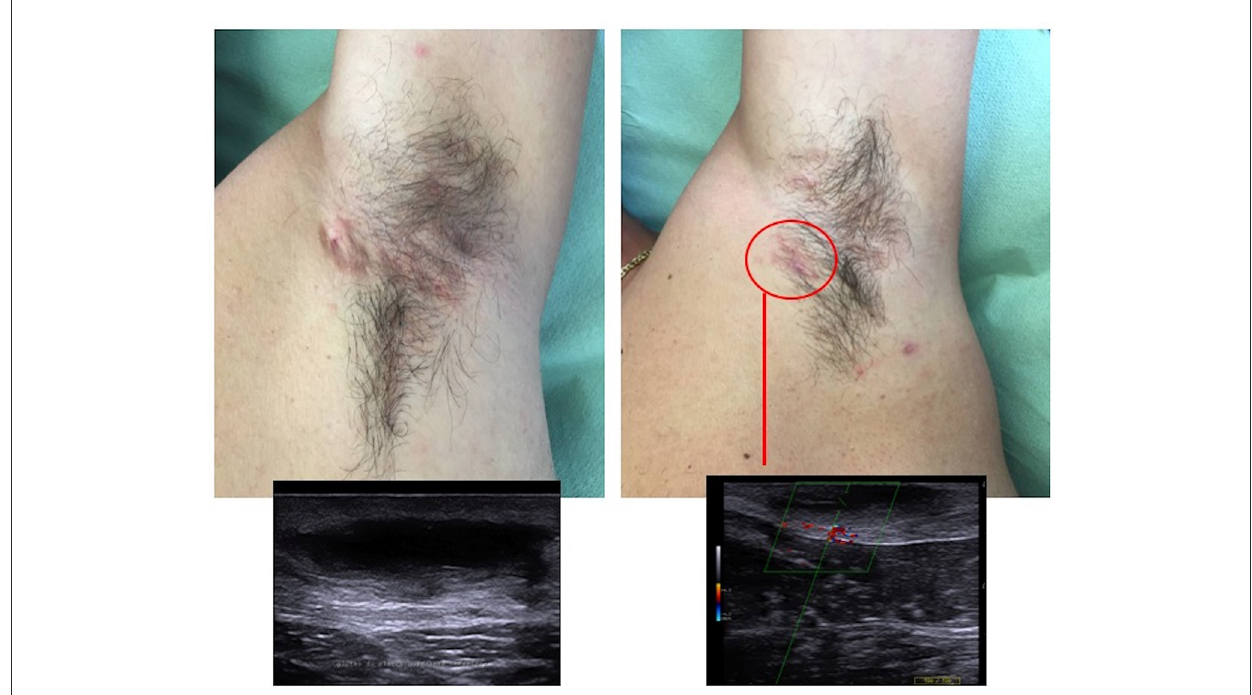
FIGURE5 Hidradenitis suppurativa lesions of the armpit before and after cryotherapy, with ultrasound assessment documenting improvement, but the persistence of a pseudocyst hypoechoic nodule with the fibrotic surrounding tissue.